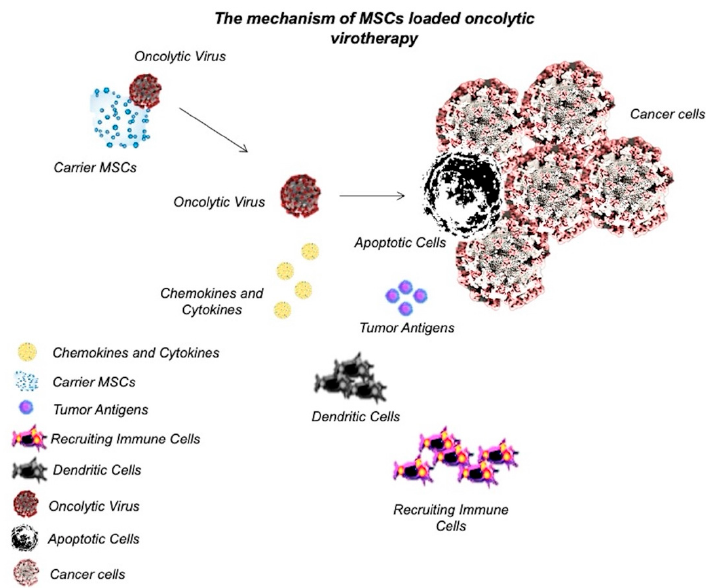
Figure 1. Mechanism of MSC-loaded oncolytic virotherapy.